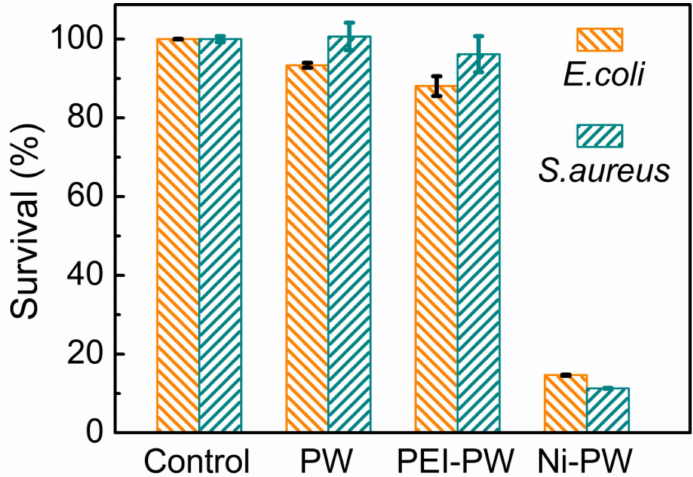
Figure 5. The bacterial survival after 24 h of incubation, measured from Figure